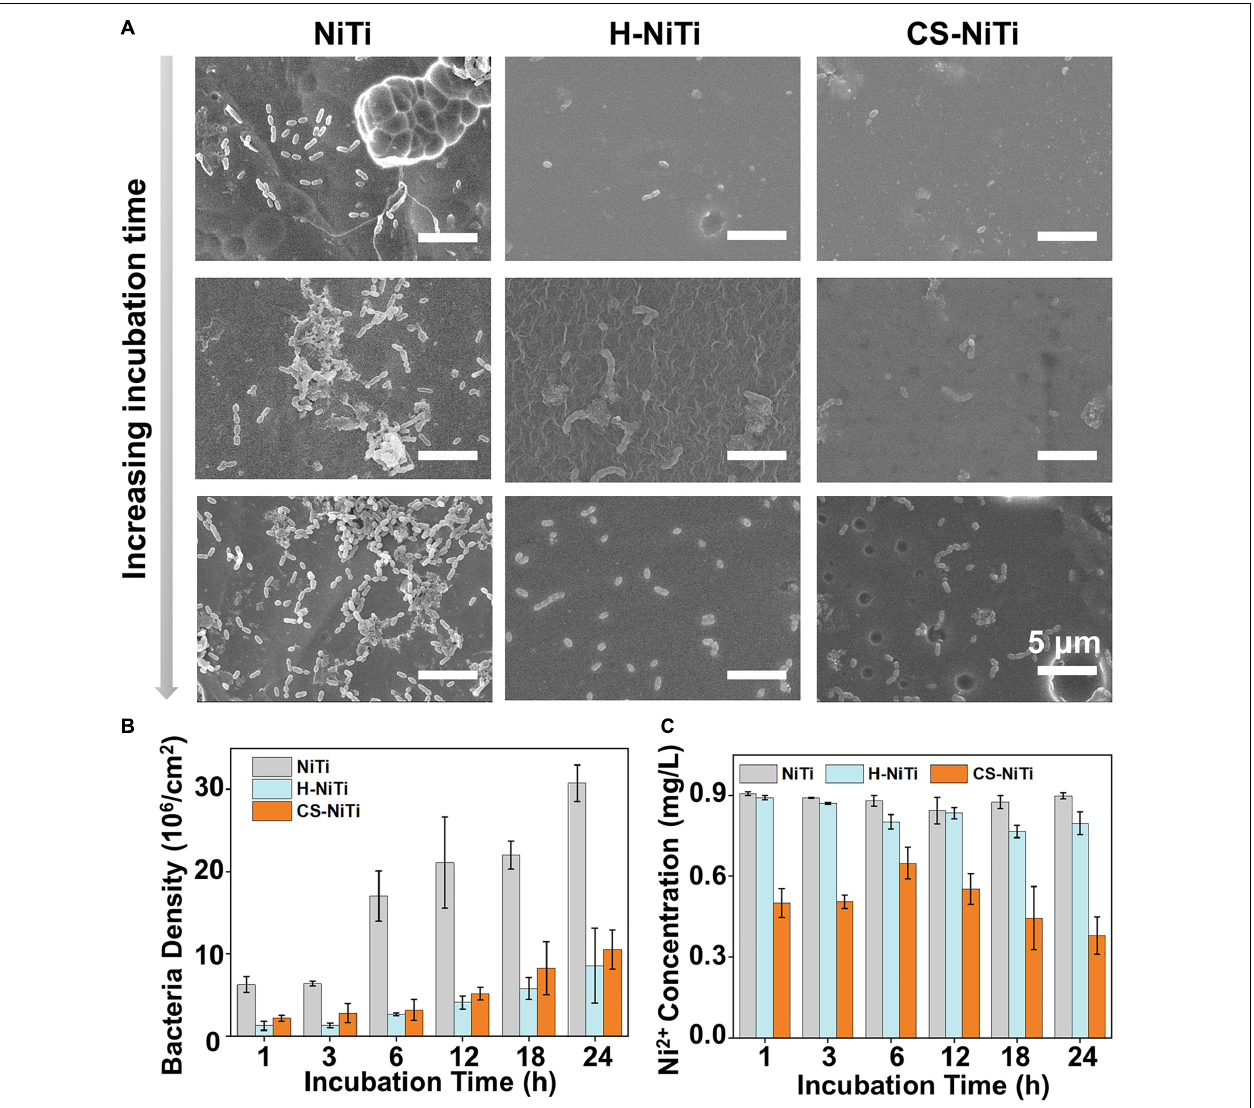
FIGURE 3 | The anti-bacteria property of CS-NiTi. (A) SEM images of pristine NiTi, H-NiTi, and CS-NiTi after being incubated with bacteria suspension for different times (1, 12, and 24 h). The quantitative analysis of bacteria adhesion (B) and Ni 2 + ion capture performance (C) on the surface of pristine NiTi, H-NiTi, and CS-NiTi at different incubation